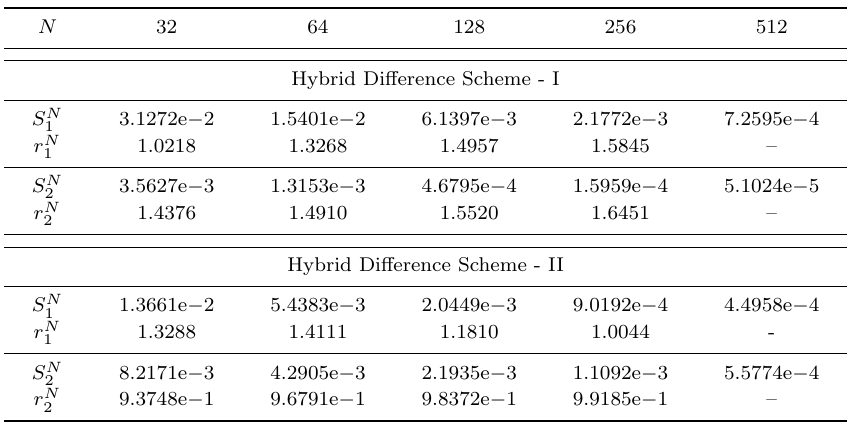
,r N and S N ,r N for the Example 1 1 2 2